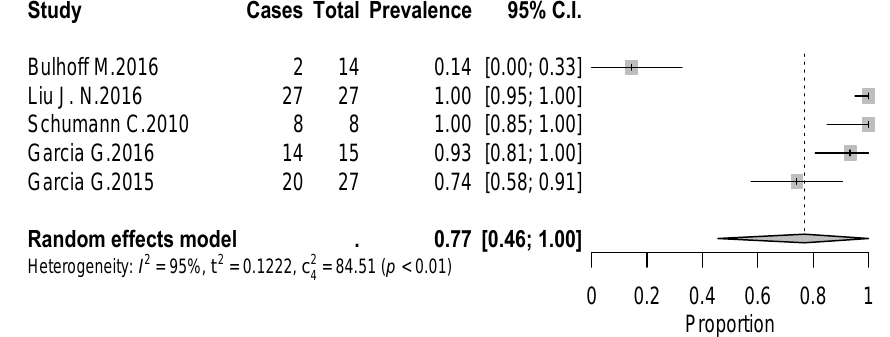
Figure 4. Forest plot chart of the rate of return to fitness after shoulder arthroplasty with 95% confidence interval.